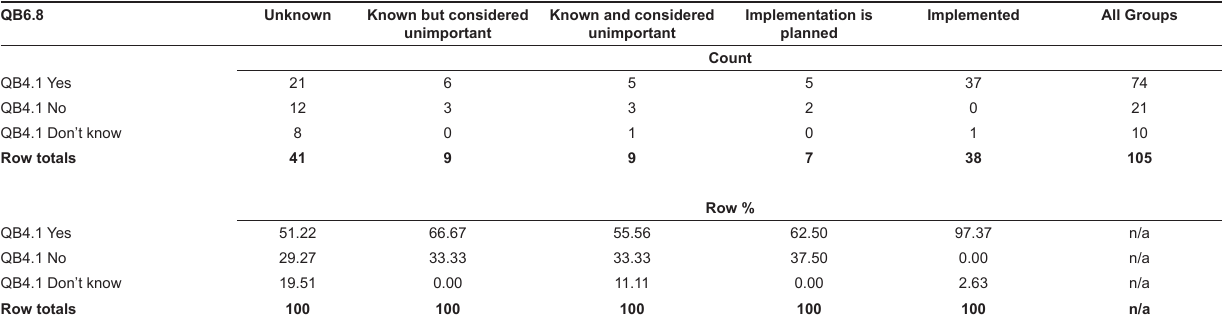
TABLE 11 Summary frequency table QB6.8(5) × QB4.1(3): top management ethical leadership and senior management